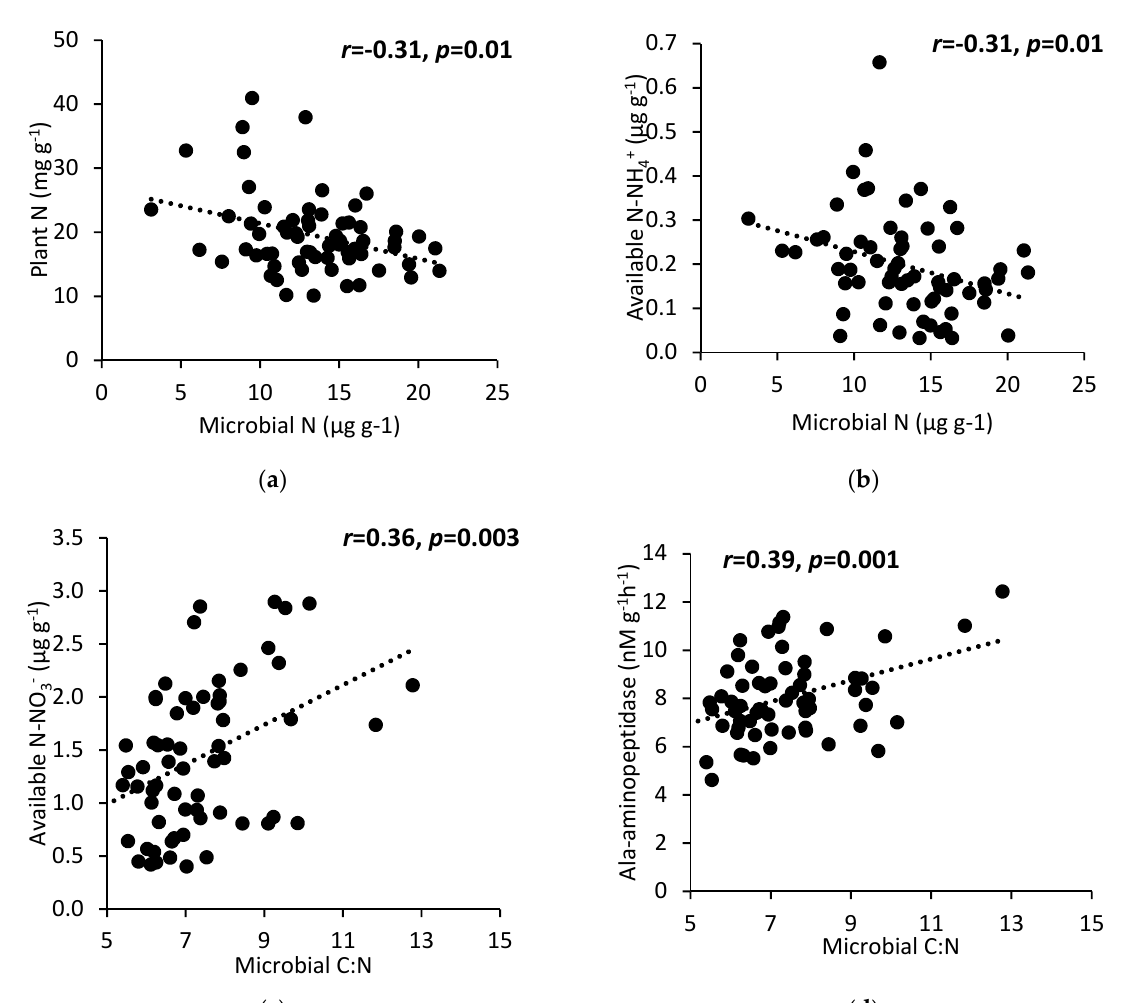
Figure 3. Correlation between C:P ratio of exudates and microbial biomass ( a ) and between soil solution N:P ratio and phosphatase potential activity ( b ).